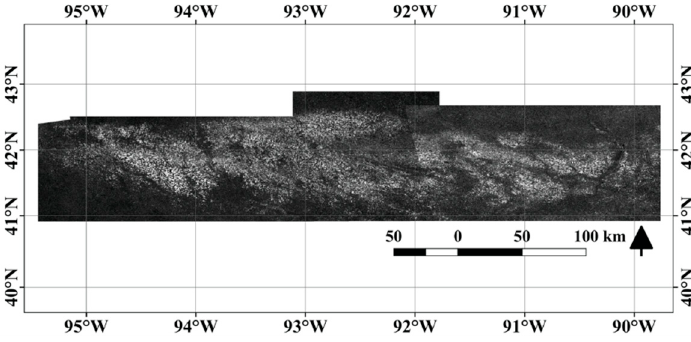
Figure 6. Spatial mosaic of all ratio maps in Figure 5a–c.